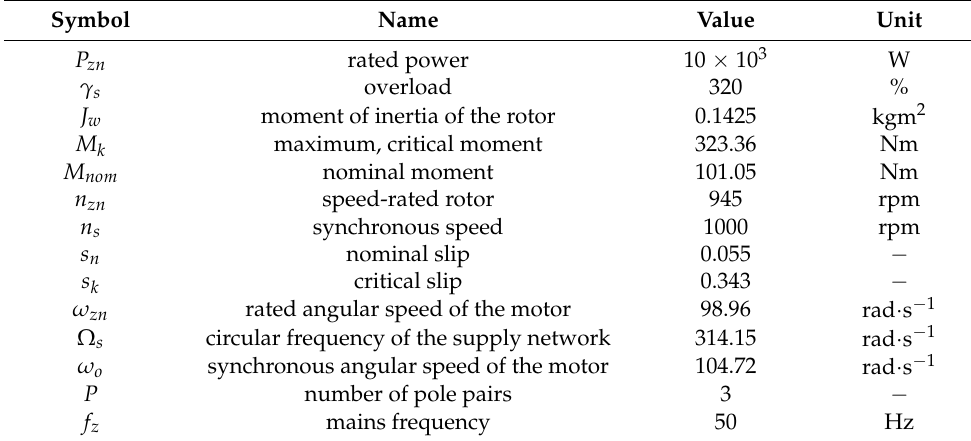
Table 2. Parameters of the modeled asynchronous